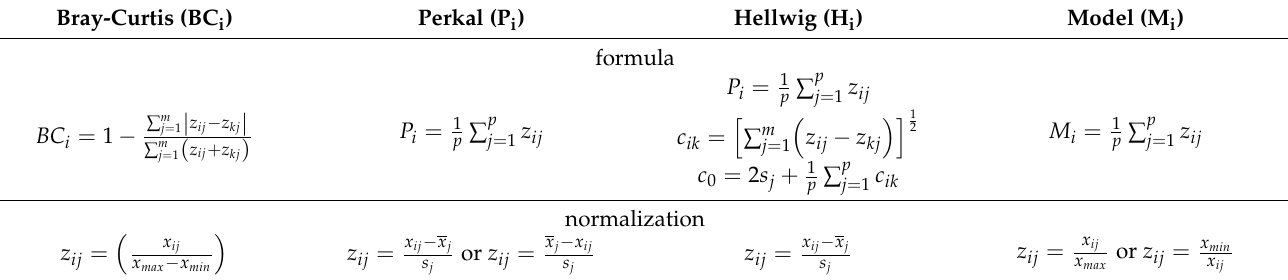
Table 3. Formulas for synthetic methods used to calculate the urban sprawl index. Bray-Curtis (BC i ) Perkal (P i